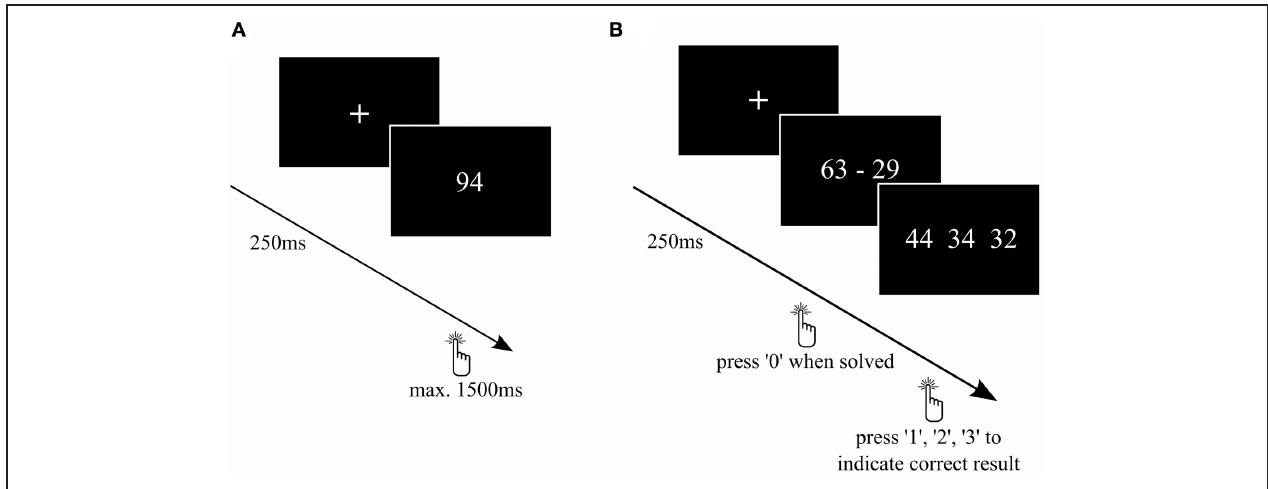
FIGURE 2 | Number comparison and complex subtraction task. (A) On every trial of the number comparison task, participants had to decide whether a number was larger or smaller than 65. (B) Subjects had to